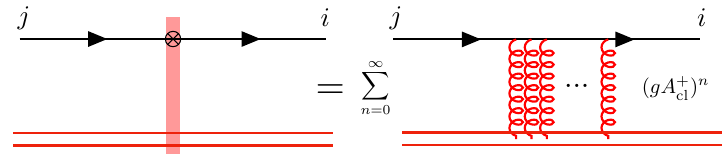
Figure 2. The interaction of a quark with the background field of the nucleus is encoded in a light-like Wilson line which re-sums multiple eikonal